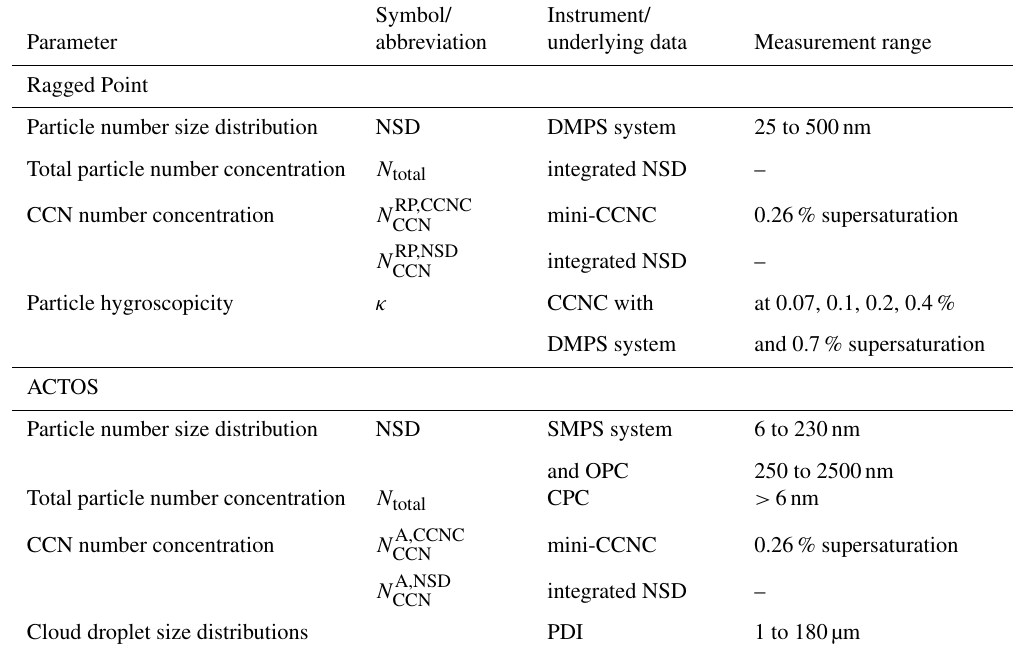
Table 1. Measured and derived parameters and the respective instrumentation used at Ragged Point and on ACTOS.